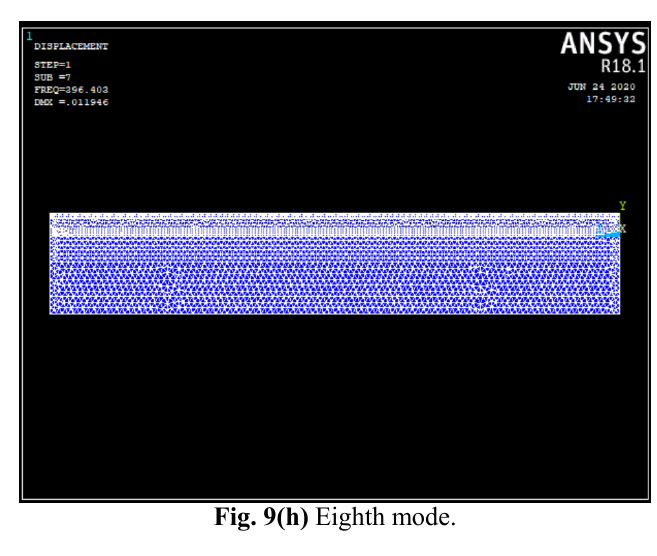
Fig. 9(h) Eighth mode.